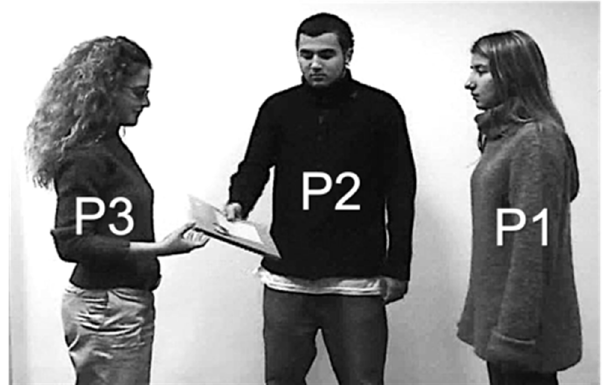
Figure 2. Coding of the “Persona” (people on the screen).